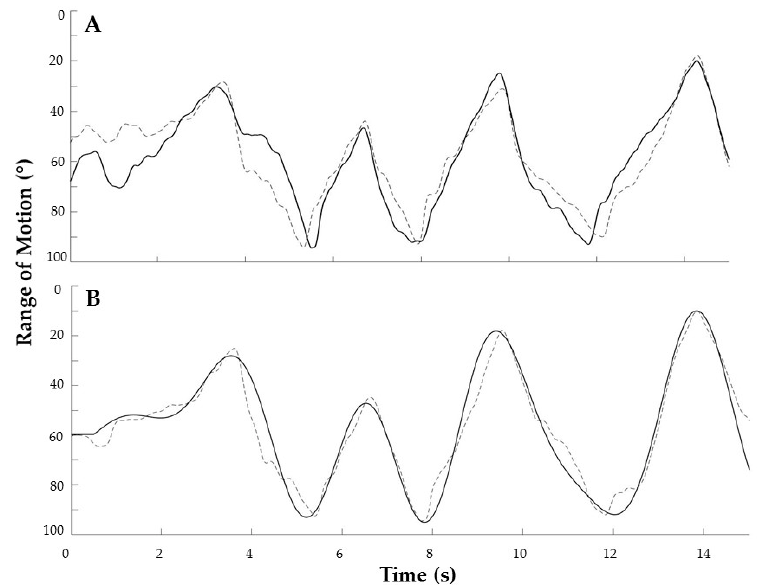
Figure 3. Position control from a representative participant before ( A ) and after ( B ) somatosensory electrical stimulation. The dashed line in panels A and B represents the target position and the thick black line depicts actual patients’ performance.